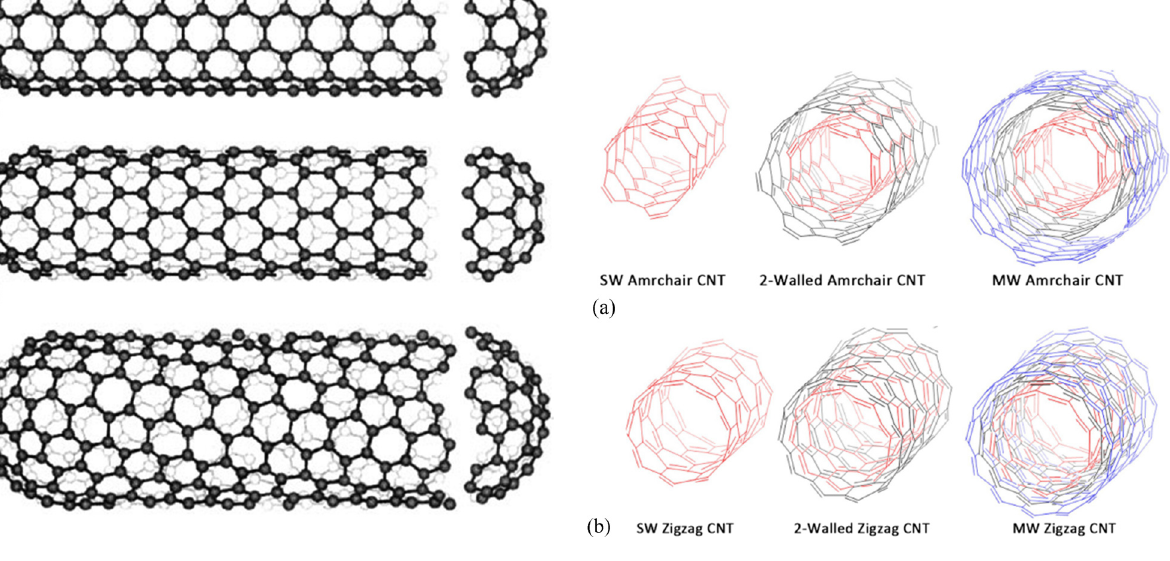
Figure 1: The three classes of the microstructure of SWCNTs: ( a ) armchair ( n , m ) = ( 5,5 ) ; ( b ) zigzag ( n , m ) = ( 9,0 ) ; and ( c ) chiral ( n , m ) = ( 10,5 ) [ 2 ] .